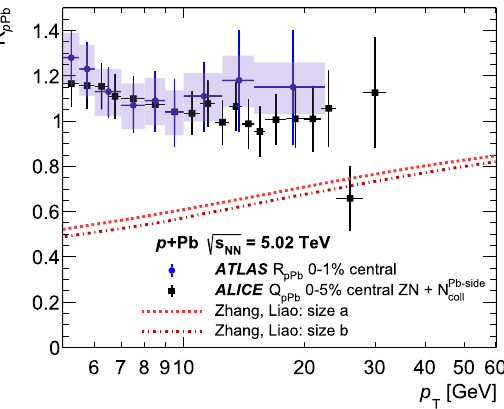
Fig. 6 Coefficients v 2 and v 3 (left panel) and R p Pb (right panel) plot- ted as a function of particle p T for p +Pb collisions. The left panel is for central 0–5% events from the jet p T > 100 GeV event sample. Sta- tistical uncertainties are shown as narrow vertical lines on each point, and systematic uncertainties are presented as coloured boxes behind the points. The left panel has two sets of curves showing theoretical predictions from a jet quenching framework with two different initial geometries in 0–4% central collisions [14]; the upper two (red/orange)